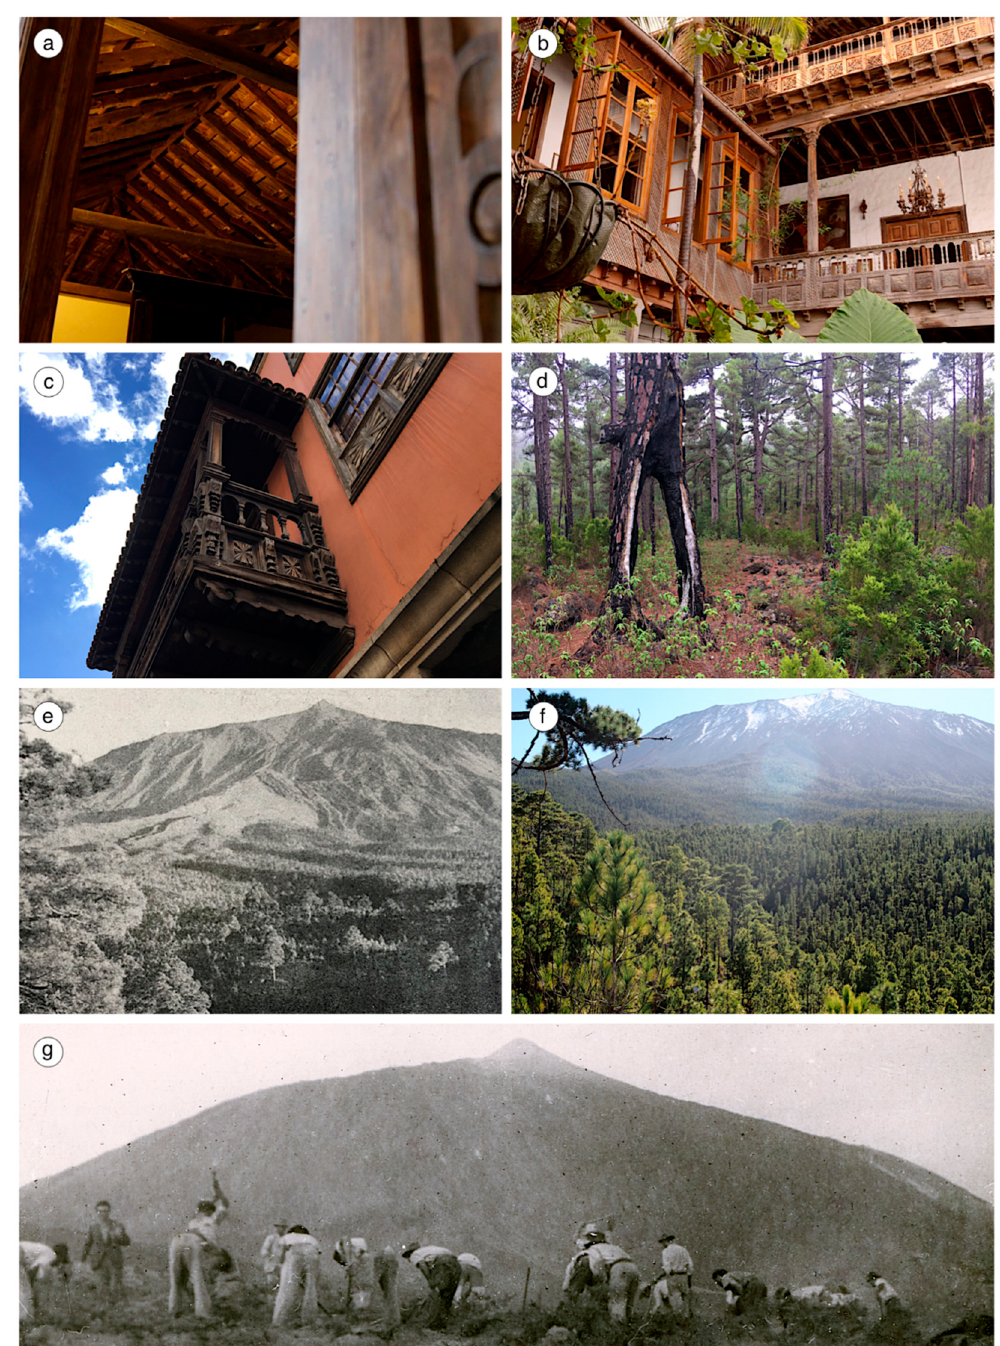
Figure 2. ( a – c ) Constructions made from Canary Island pine wood in the municipality of La Orotava (Tenerife). Casa de Los Balcones, 17th century. ( a ) Wooden ceiling structure; ( b ) exterior carpentry and wooden balcony; ( c ) typical wooden balconies; ( d ) Canary Island pine wounded to obtain pitch for caulking ships and subsequently affected by fire; ( e ) Icod Pine Forest, 1951 (Fototeca Forestal Española DGB-INIA (Ref. 418) [6]); ( f ) Icod Pine Forest, 2019 (Photo by Javier León); ( g ) plantations in Mount Teide forest, 1951 (Montse Quintero photographic archive).